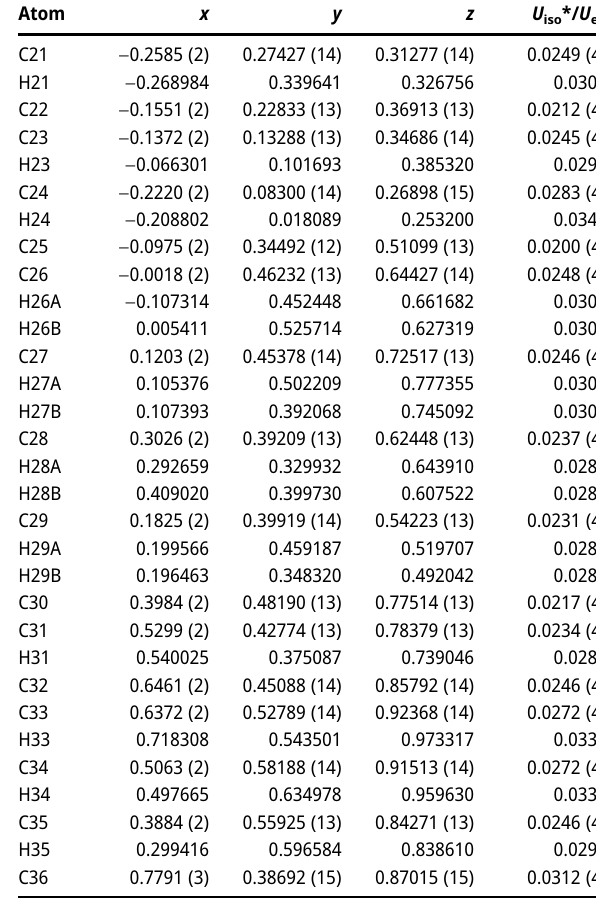
Table  : Fractional atomic coordinates and isotropic or equivalent isotropic displacement parameters (Å 